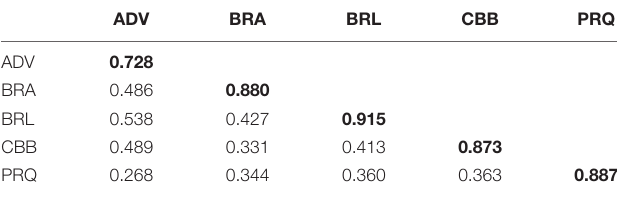
TABLE 3 | Fornell-Larcker criterion.